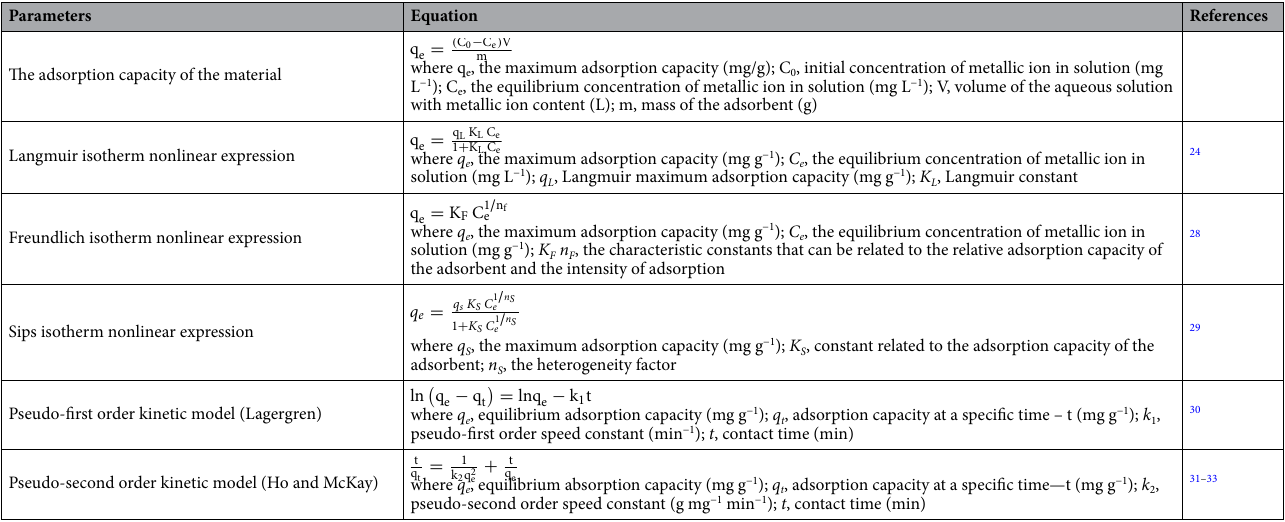
Table 1. Equations used to describe adsorption equilibrium and adsorption